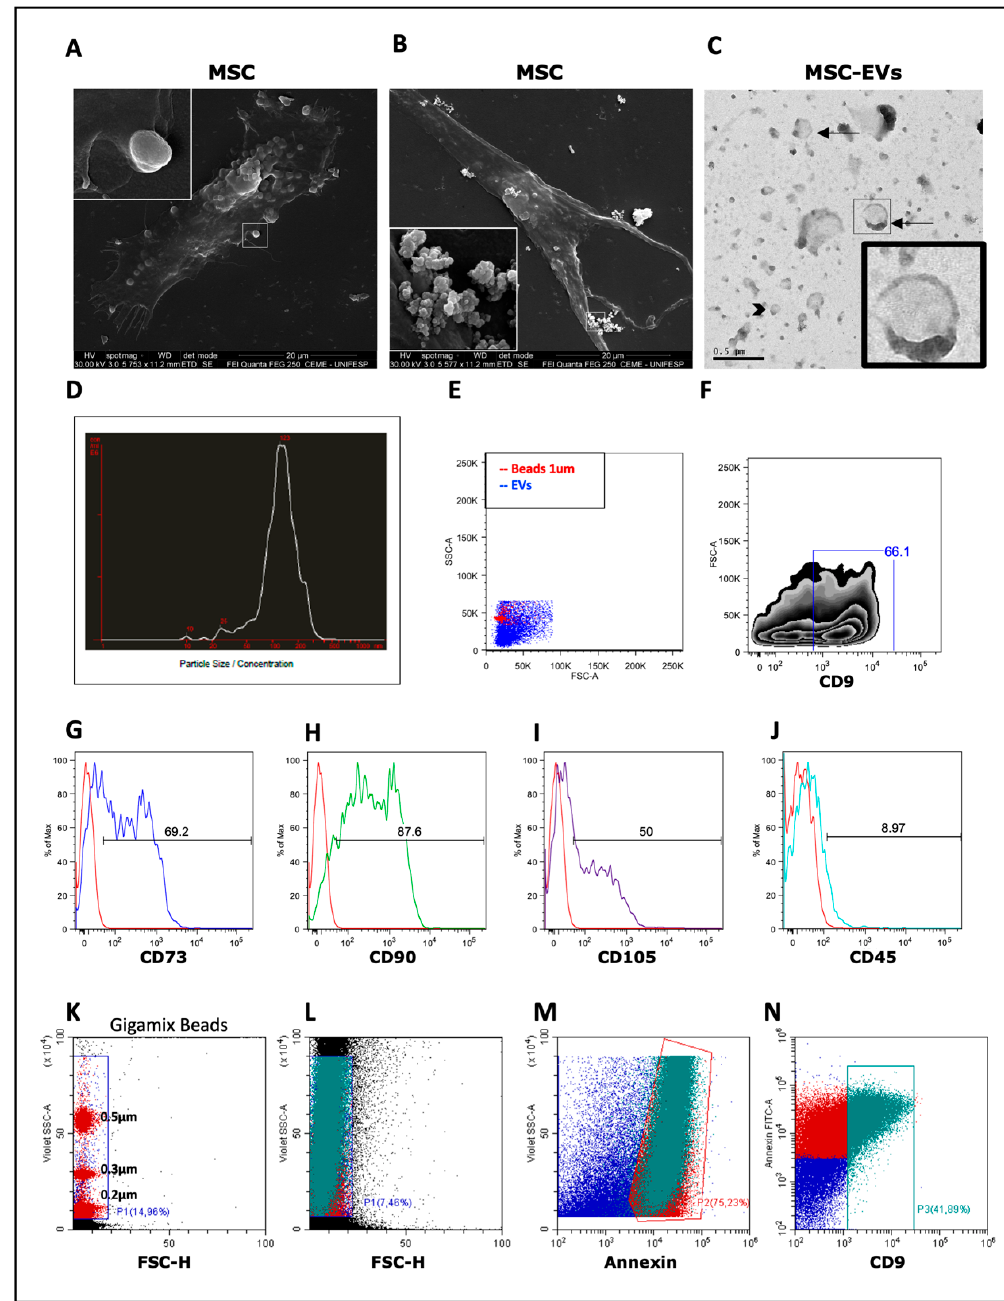
Figure 1. Characterization of mesenchymal stromal cell extracellular vesicles (MSC-EVs): To verify EVs releasing, mesenchymal stromal cells (MSCs) were visualized in a scanning electron microscope ( A,B ). The release of vesicles of different sizes was demonstrated. In A, a larger vesicle is budding from the cell membrane, while in B a pool of smaller vesicles is released. MSC-EVs were visualized in a transmission electron microscope, showing the characteristic double membrane structure. Arrows indicate larger vesicles, compatible with microvesicles, whereas arrow heads indicate smaller vesicles, compatible with exosomes ( C ). To obtain the distribution of size and concentration (particles/mL), MSC-EVs were analyzed by NanoSight ( D ). The extracellular vesicles (EVs) were analyzed by flow cytometry analysis (FACS), using 1- μ m beads as reference ( E ) and labeled with anti-CD9 ( F ). Expression of present and absent markers of MSCs was also evaluated in MSC-EVs with anti-CD73, CD90, CD105 and CD45 antibodies ( G-J ). MSC-EVs were evaluated by CytoFLEX where they were gated based on Gigamix beads size ( K,L ) and stained for Annexin ( M ) and CD9 ( N ).